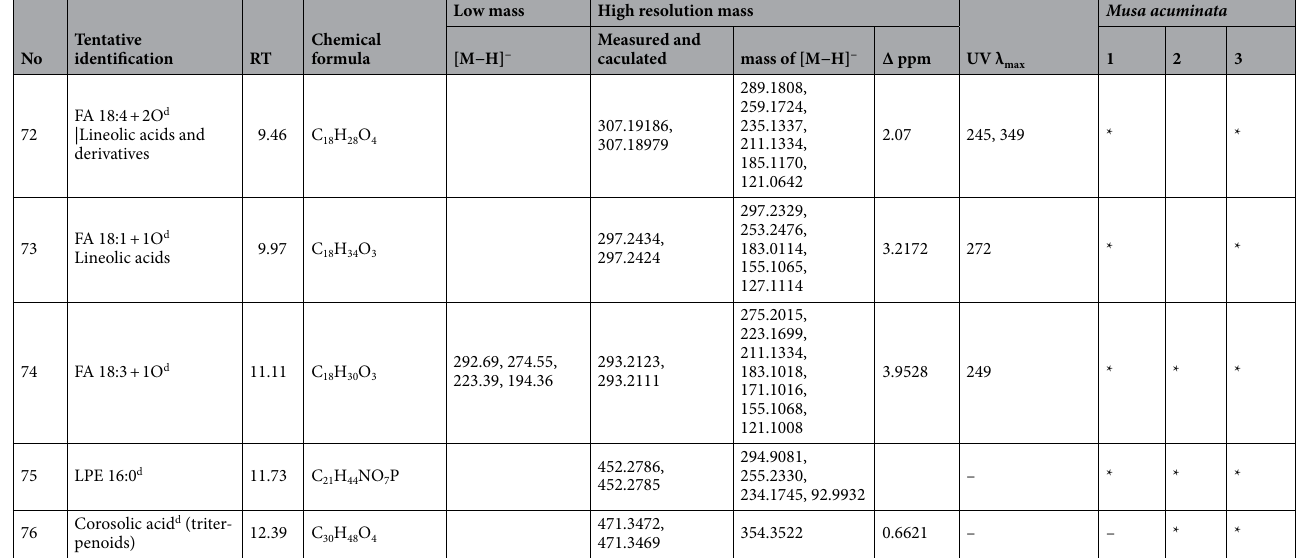
Table 2. HPLC and LC-MSMS data in low and high resolution of different MA parts identified by tentative mass. Compounds listed in the Table were found in (1) total extract of leaves MA , (2) Pesudostem, and (3) Fruit Peels, (a) compounds compared with literature 7,40–43 , (b) compounds identified from Standard Authentic compound Quantitative with HPLC (conc. as µg/g), (c) compounds identified from NMR , (d) compounds identified from DataBase (MS-Dial, KNApSAcK , Metlin, and RIKEN